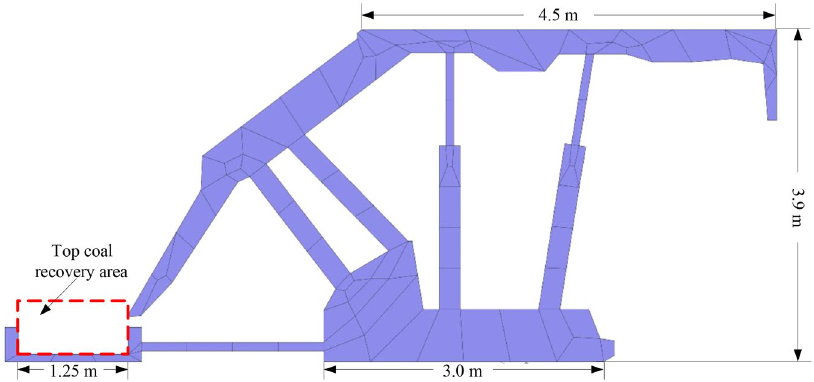
Figure 1. Model and size of shield used in numerical